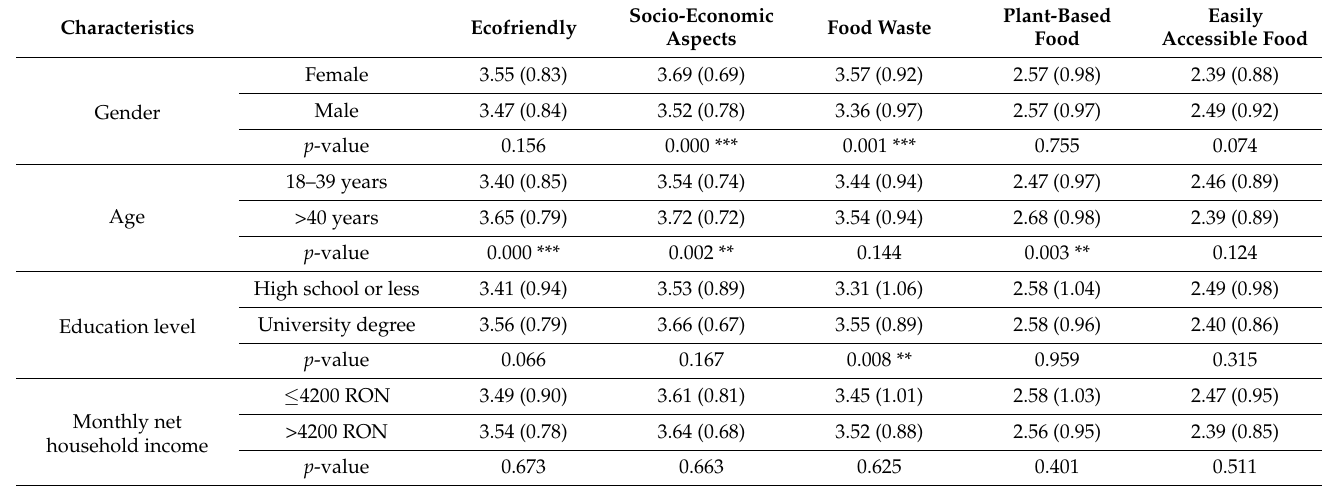
Table 3. Relationship between the socio-demographic characteristics and PCA